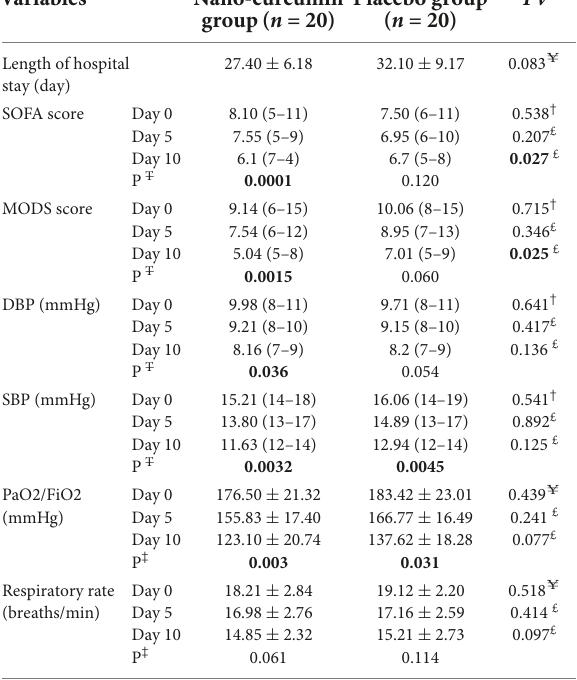
TABLE 7 Effect of curcumin on clinical outcomes are presented for the participants. Variables Nano-curcumin Placebo group group ( n = 20) ( n =